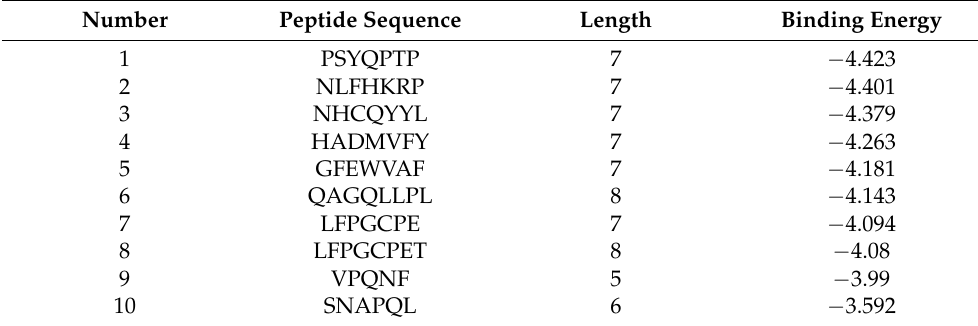
Table 7. Molecular docking modeling energy scores and interaction results of nine peptides obtained from WPH.